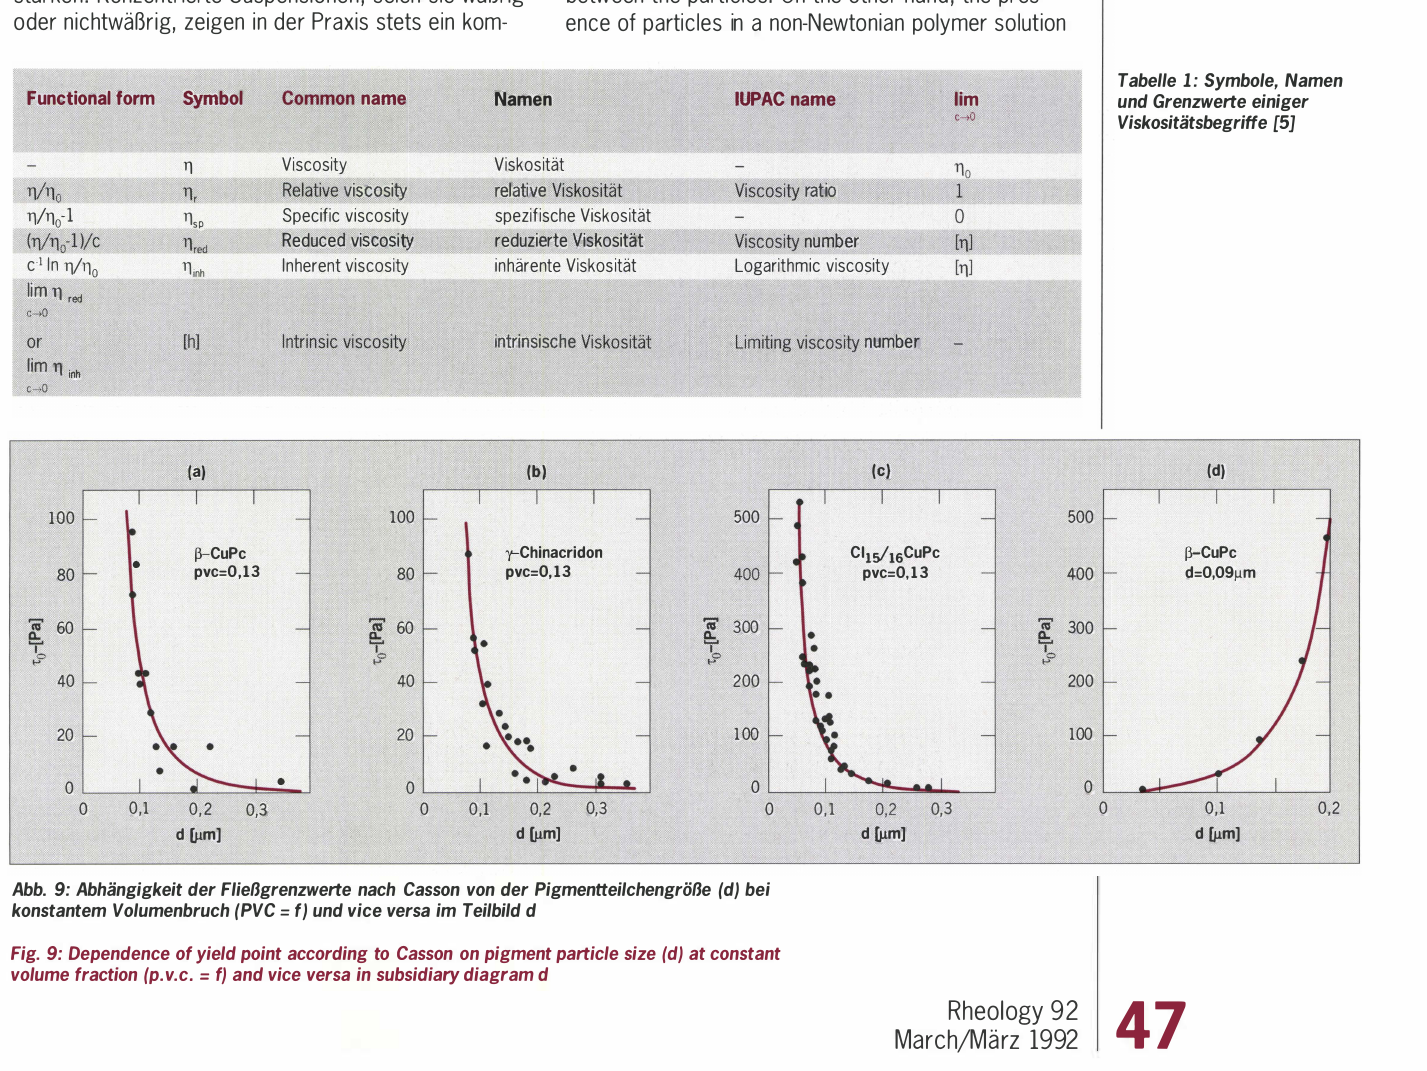
Tabelle 1: Symbole, Namen und Grenzwerte